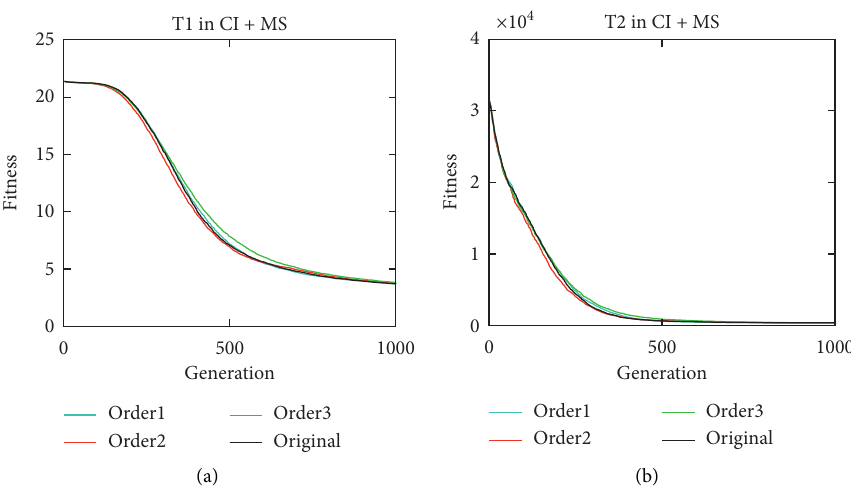
Figure 14: Convergence of MFDE for problem 2 (CI +MS).